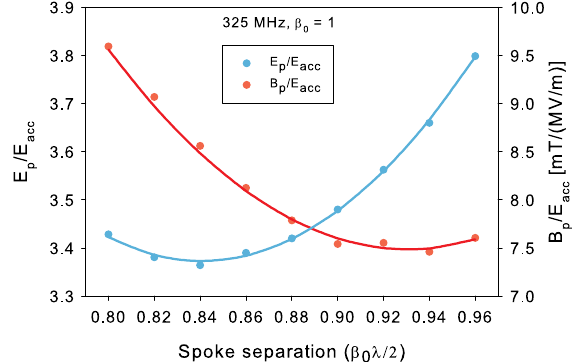
FIG. 24. Dependence of the normalized electric and magnetic fields on spoke separation, for a spoke angle of 36 (cid:5) .